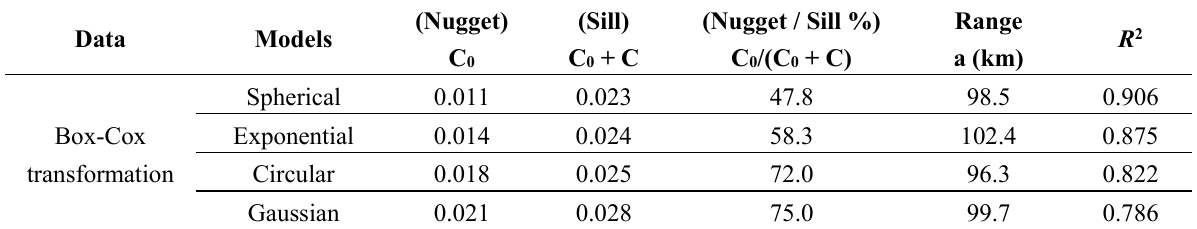
Table 3. Theoretical semivariogram model and the corresponding parameters for forest biomass carbon